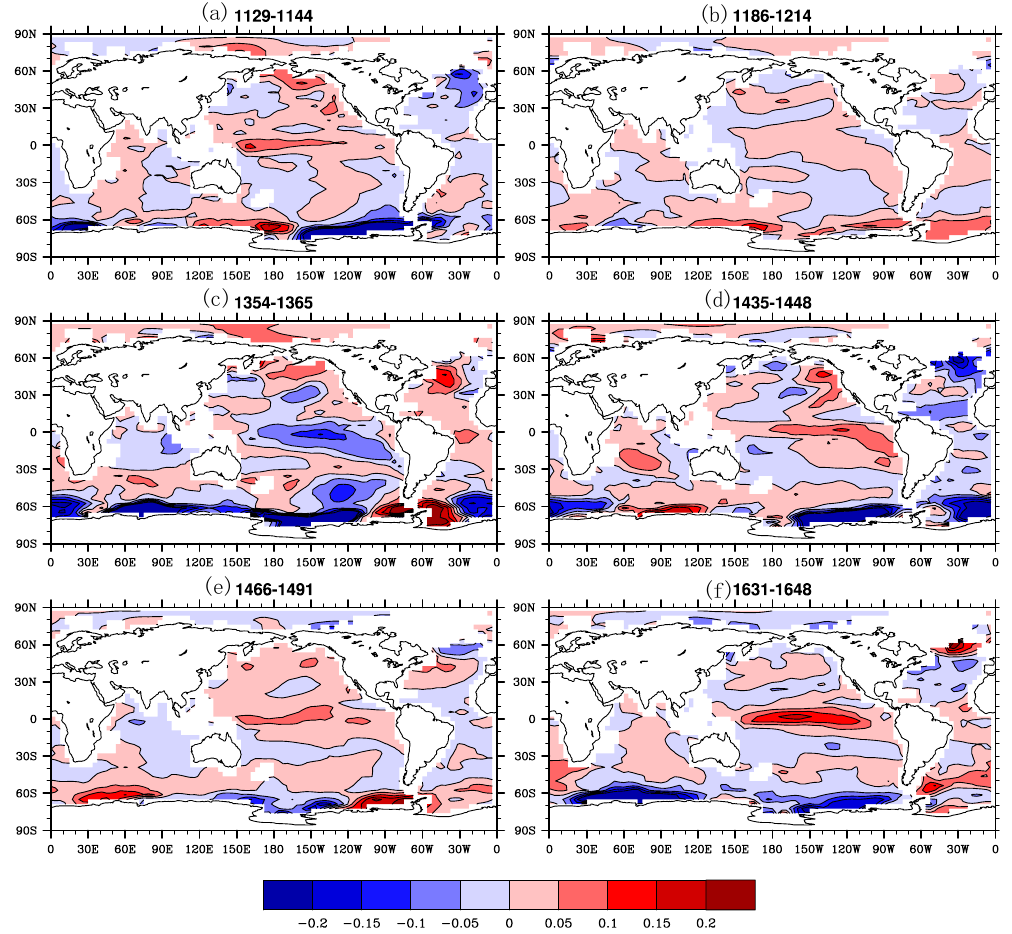
Figure 8. Same as Fig. 2 but for the 100-year high-pass filtered global sea surface temperature anomalies map of the six well-captured droughts. The 100-year high-passed data were used because a strong warming in SSTs in the modern period may exaggerate the cold SST anomalies during the